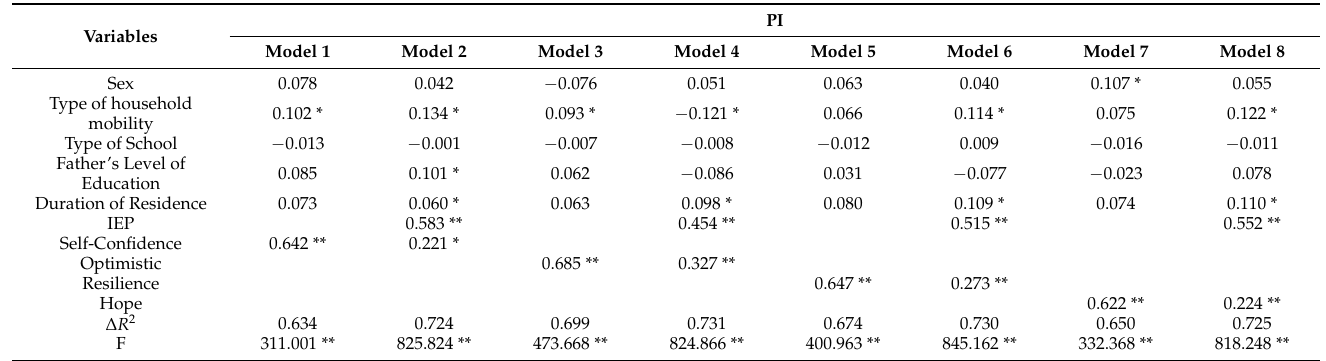
Table 5. Moderating effect of PC on the relationship between IEP and